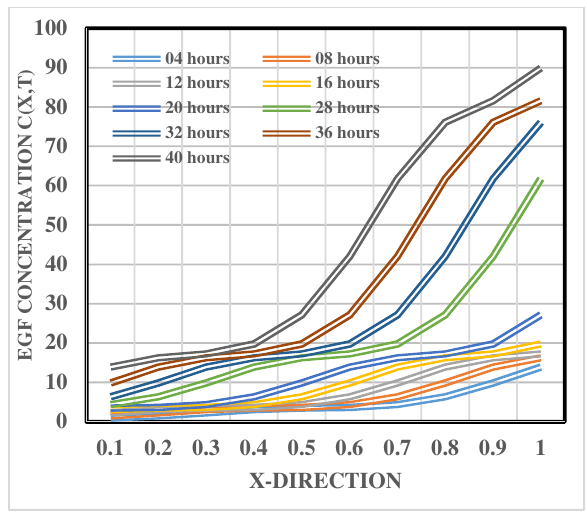
Fig. 7. Cell concentration for EGF for 10 steps of time with 4 hours per each, and through the length from the limbus to the center of the eye.